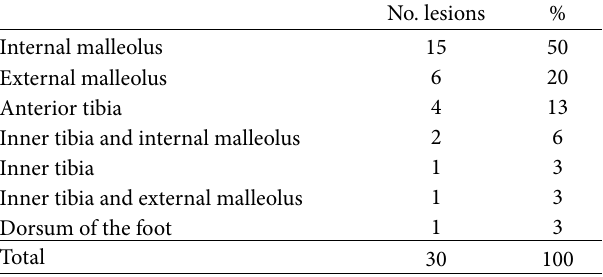
Table 5: Anatomical location of lesions.